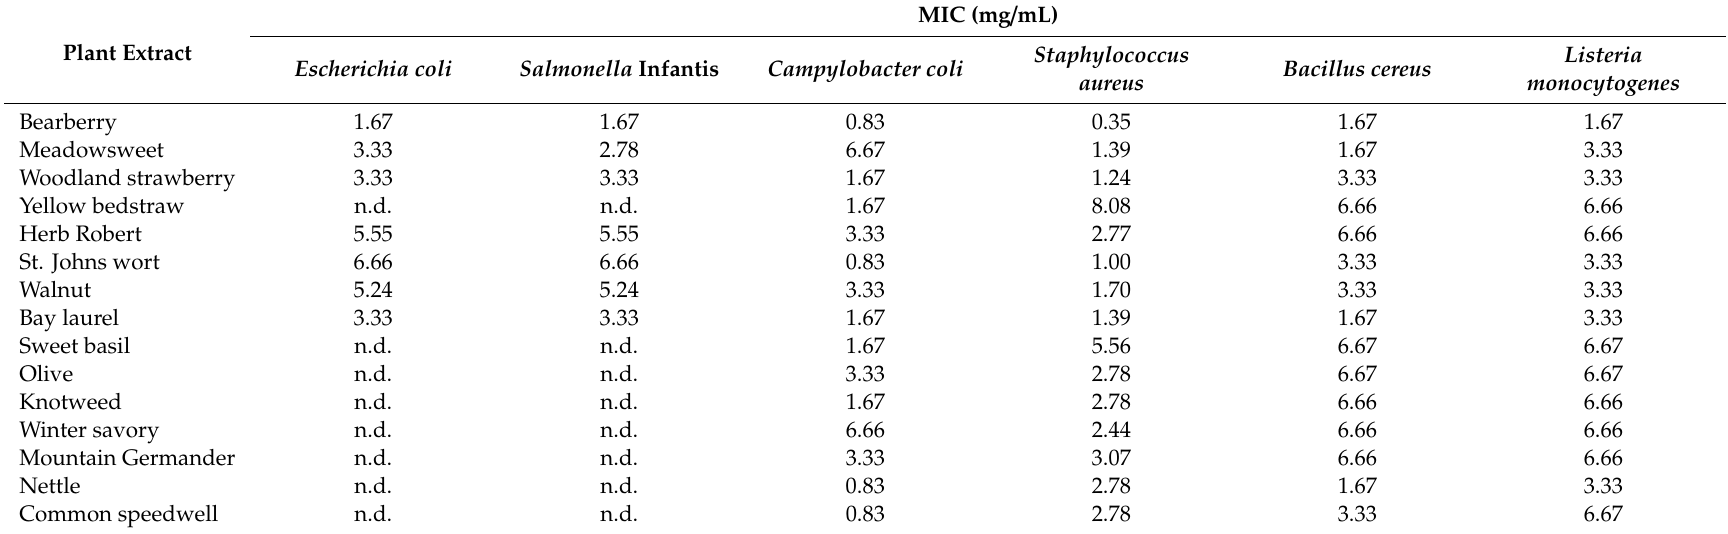
Table 5. Antibacterial activity of plant extracts expressed as minimal inhibitory concentration (MIC).